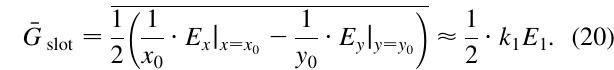
FIG. 6. (Color) E the slot resonator for the energy W (cid:4) 3 MeV at E 40 MV = m